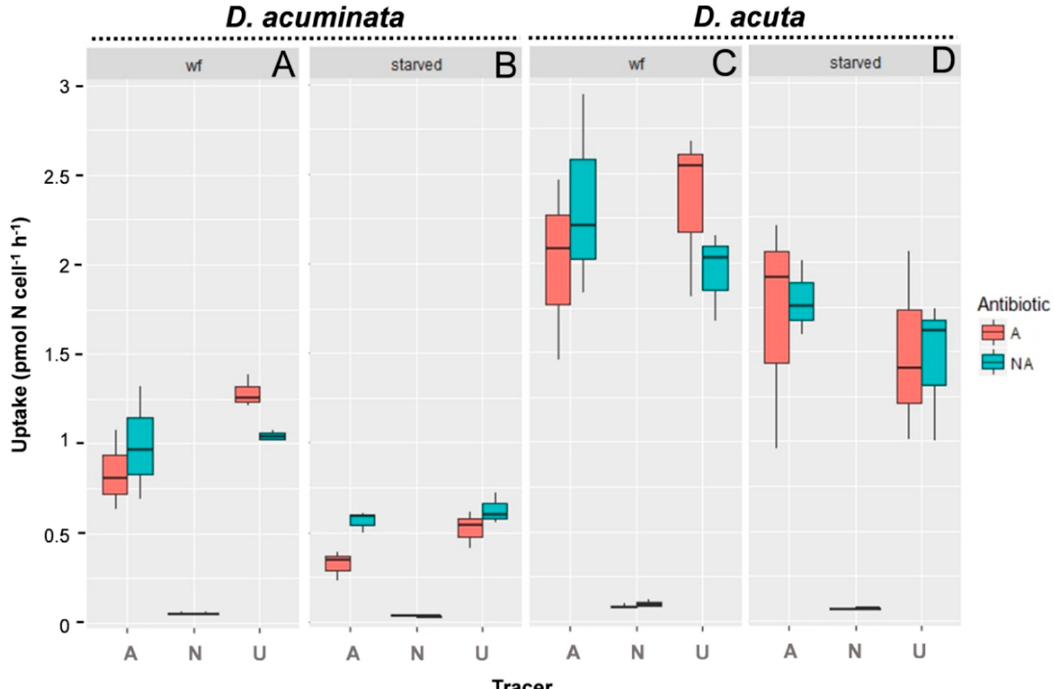
Figure 3. Uptake rates of different radio-labeled nitrogen sources (A: ammonium, N: nitrate and U: urea) by ( A ) well-fed and ( B ) starved cells of D. acuminata and by ( C ) well-fed and ( D ) starved cells of D. acuta ., with antibiotics (A) or without antibiotics (N.A.) added. Table 2. Statistical significance of uptake rates of N sources by D. acuminata and D. acuta in well-fed and starved conditions, with and without antibiotics. 2w-ANOVA: two-way ANOVA. Asterisks (*) indicate high statistical significance.